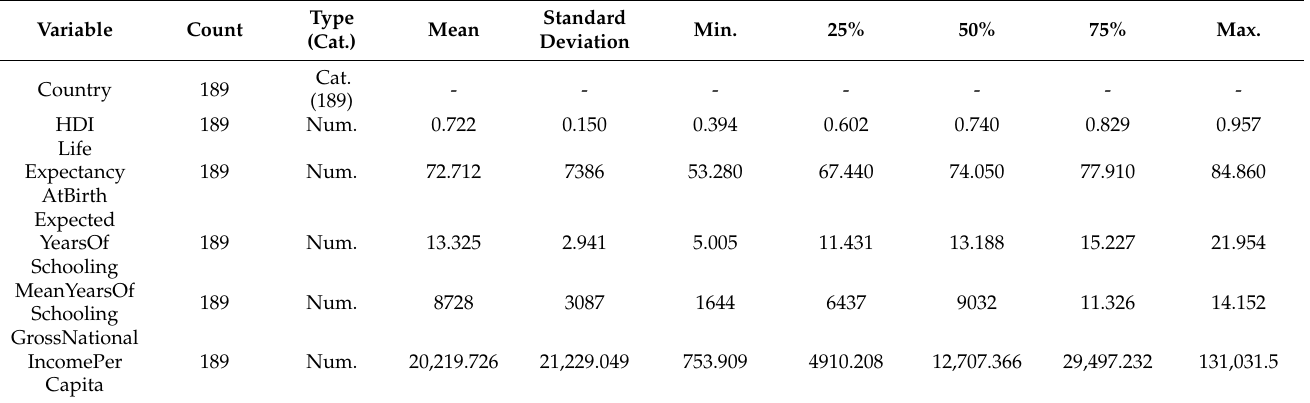
Table 3. UNDP Dataset [21] Summary